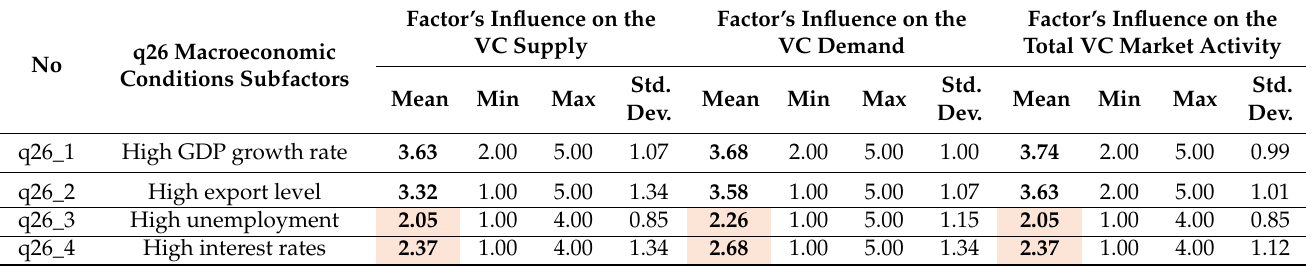
Table 16. The subfactors related to the macroeconomic conditions.